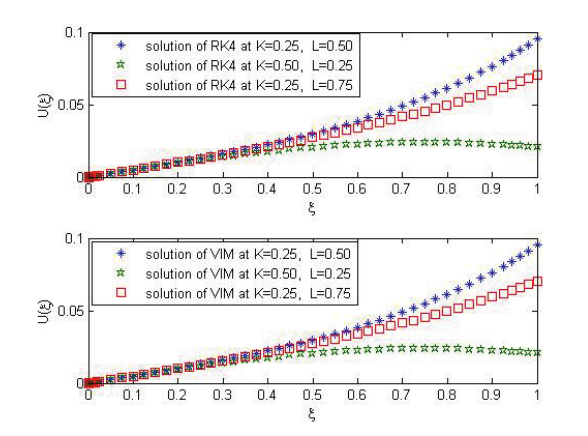
Fig. 1: The behavior of the approximate solution using RK4 (Top) and VIM (Bottom) with different values of α and β .